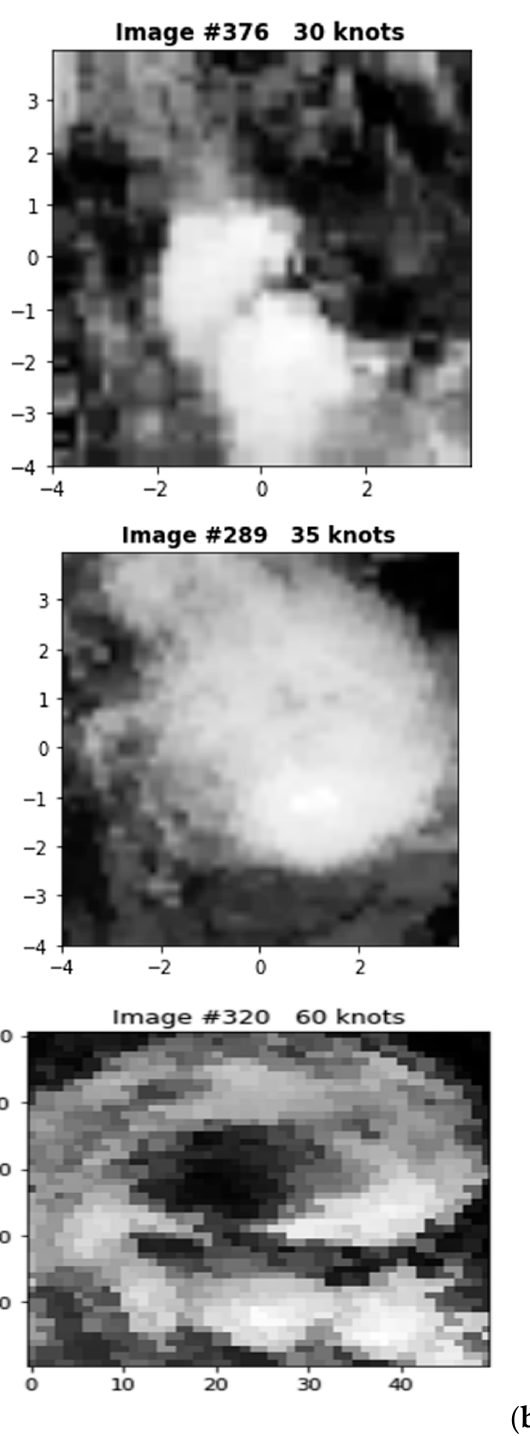
Figure 13. ( a ) Sample satellite images after data augmentation. ( b ) Generation of satellite images after data augmentation.